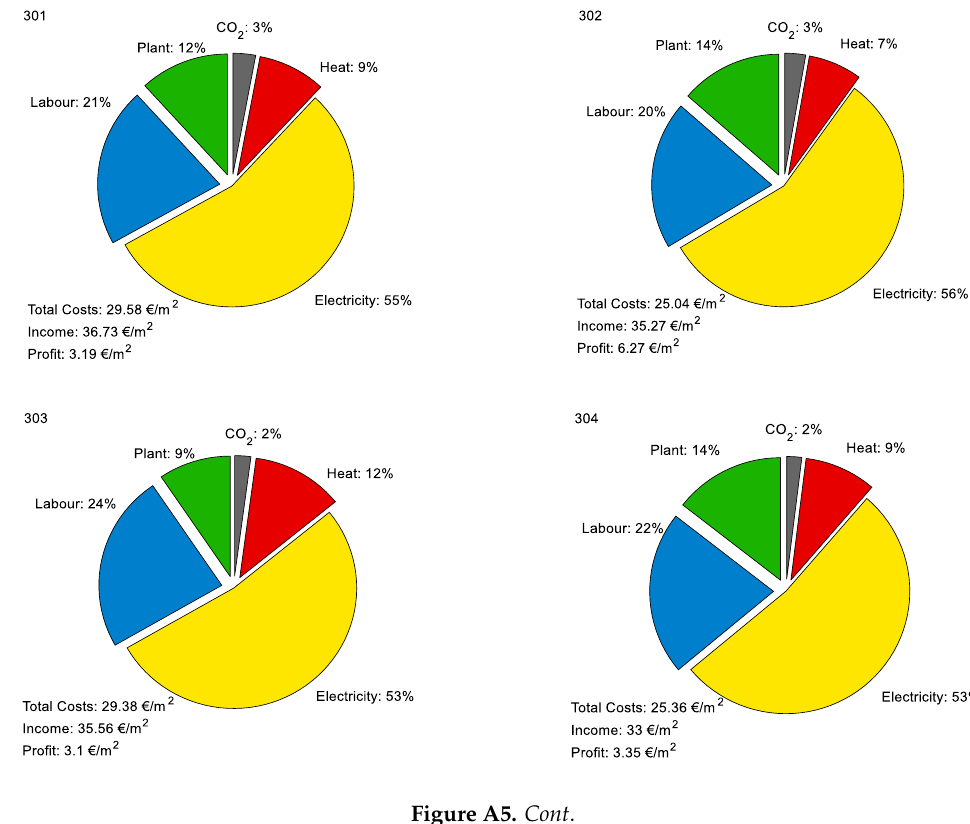
Figure A5. Net profit (€/m 2 ), different realized cost components (heat, electricity, CO 2 , plant and labor), income and net profit in different greenhouse compartments (301-306) during the experiment. Figure A6. Measured and simulated greenhouse air temperature ( o C) after automated distillation of climate strategies during the experimental period (16 December 2019 until 29 May 2020) for one of the compartments (301).